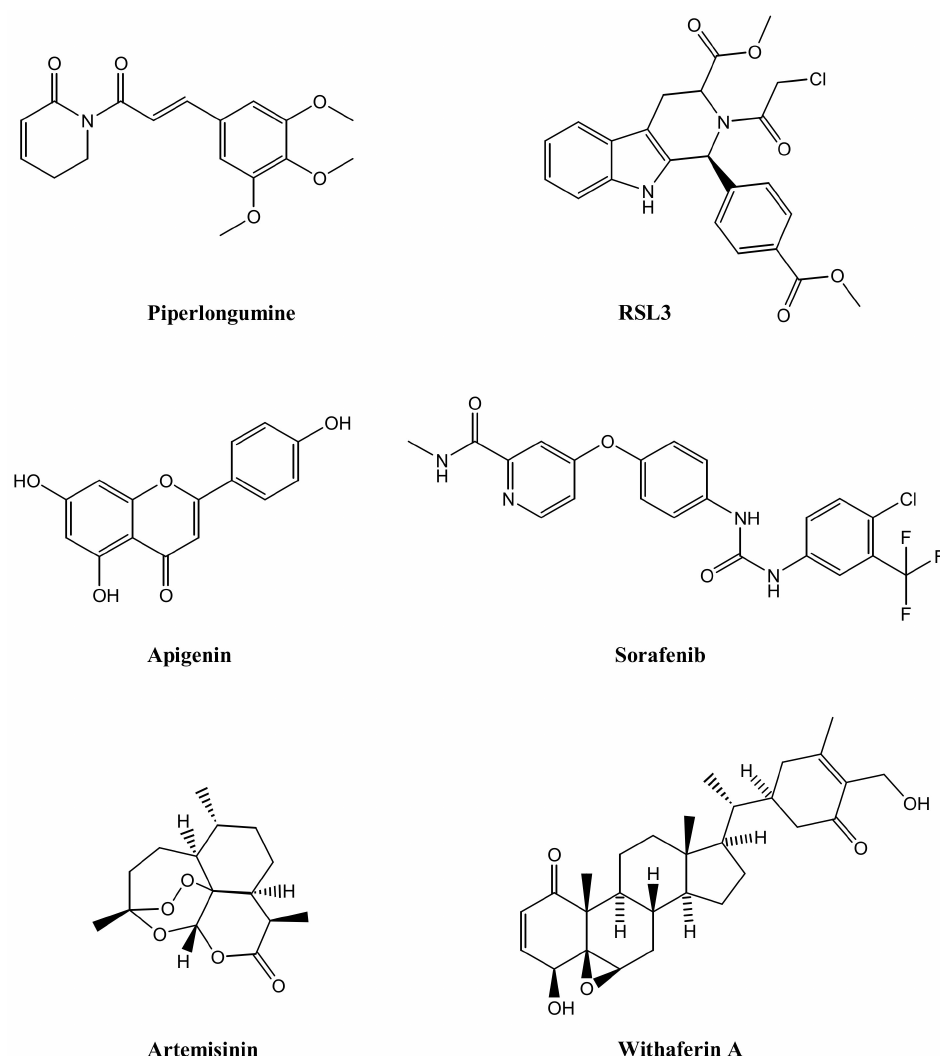
Figure 3. Chemical structures of small molecules inducing ferroptosis loaded on